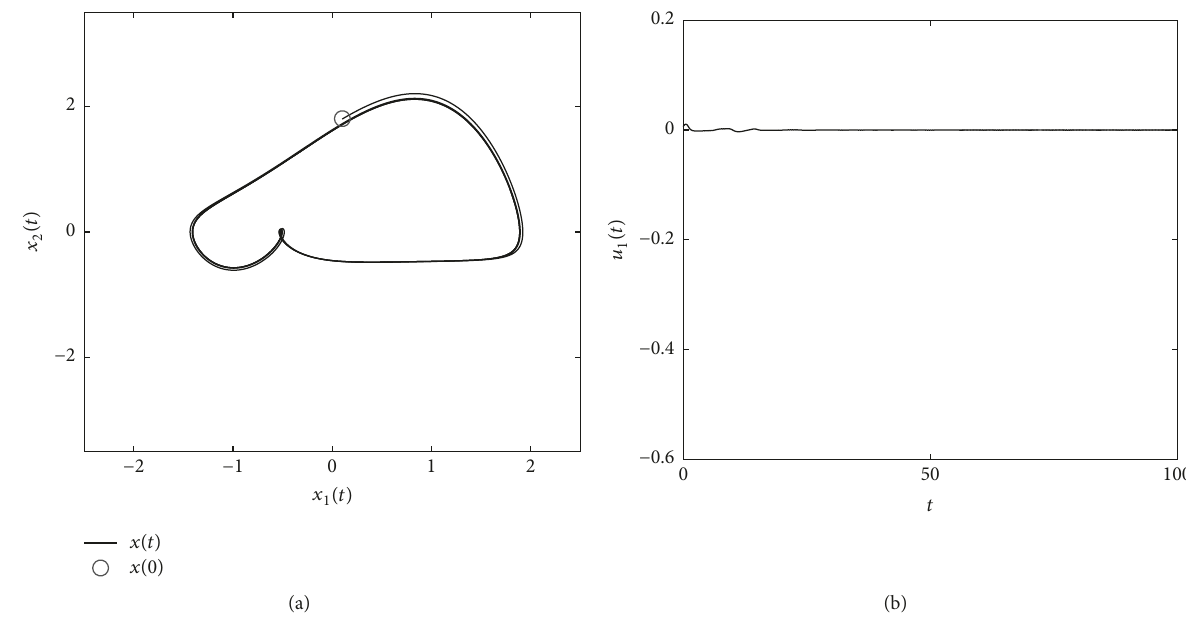
Figure 16: TUPO2 of forced vdP oscillator stabilized using aPBC with 𝑘 = −0.125 and 𝑥(0) = [0.1 1.8] 𝑇 . (a) State space trajectory and (b) time-series of the control effort.